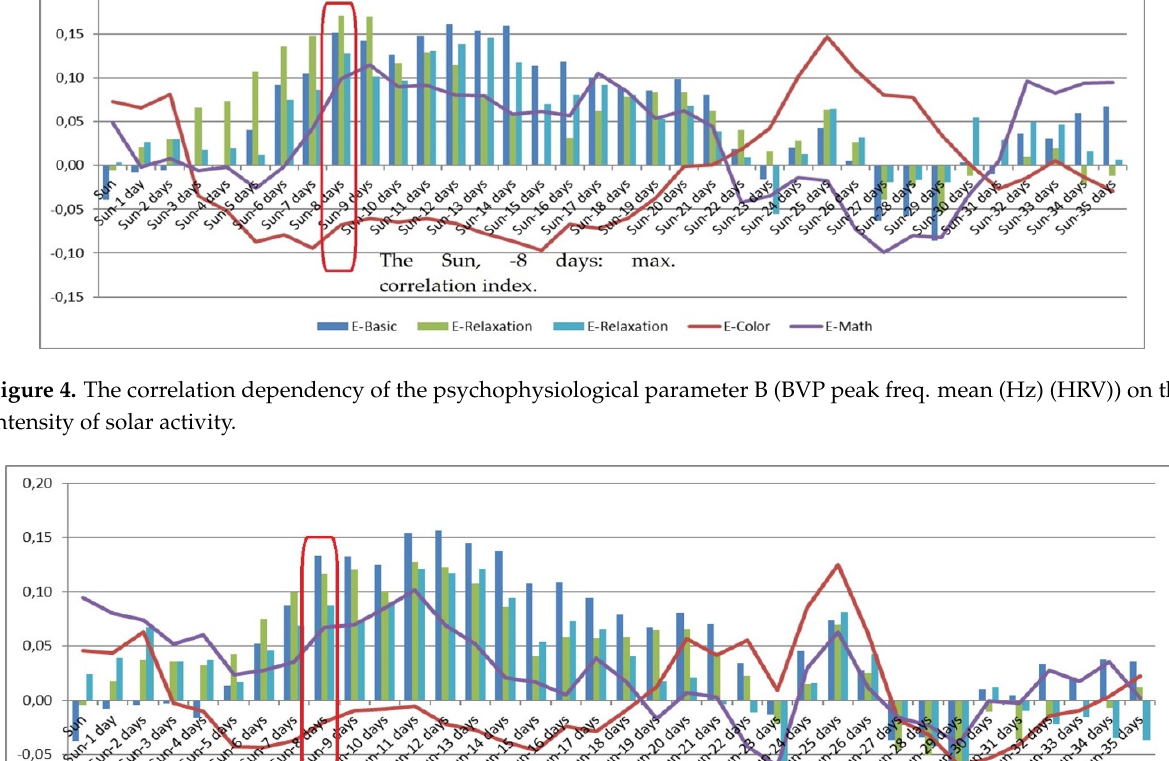
Figure 4. The correlation dependency of the psychophysiological parameter B (BVP peak freq. mean (Hz) (HRV)) on the intensity of solar activity.